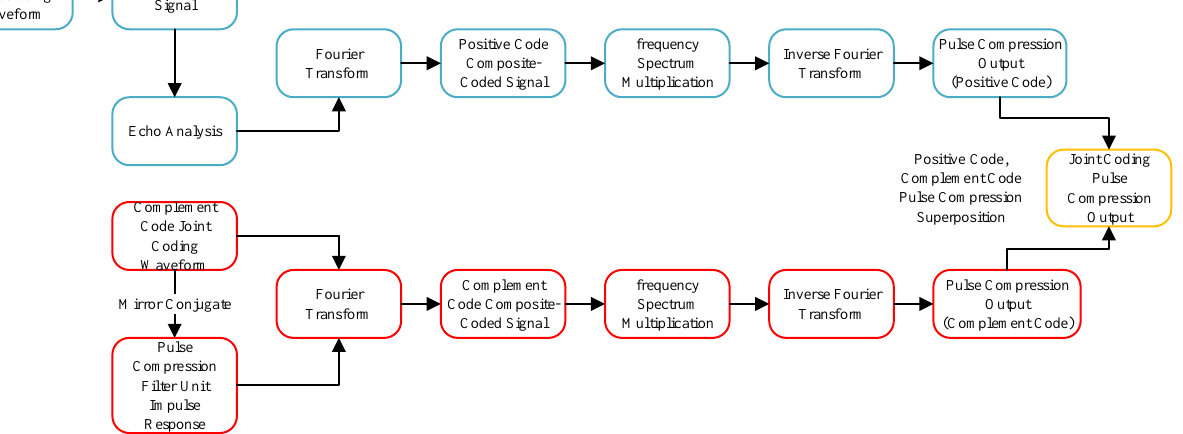
Figure 9. Pulse Compression Model of Joint coding Waveform Based on LFM.